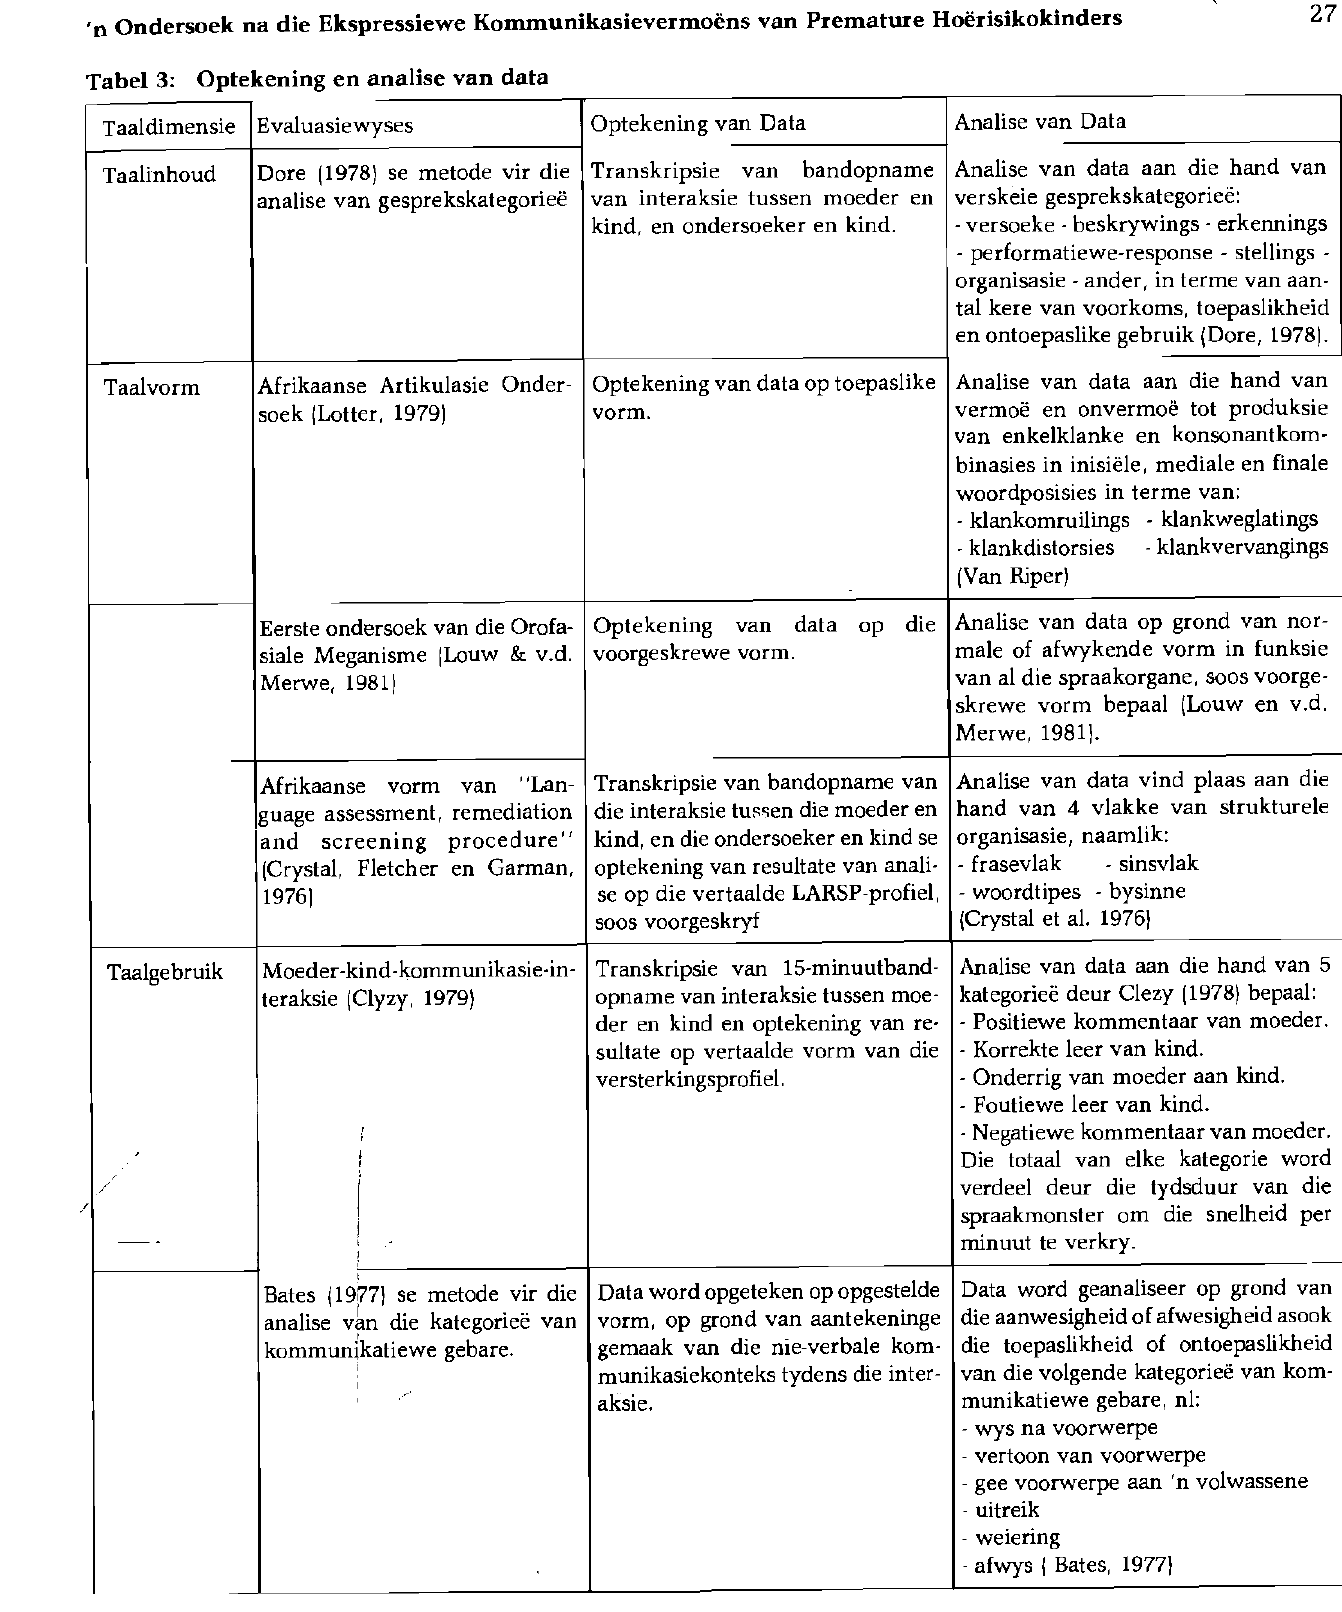
vermoens van die proefpersone gedek en word volgens hier- die indeling